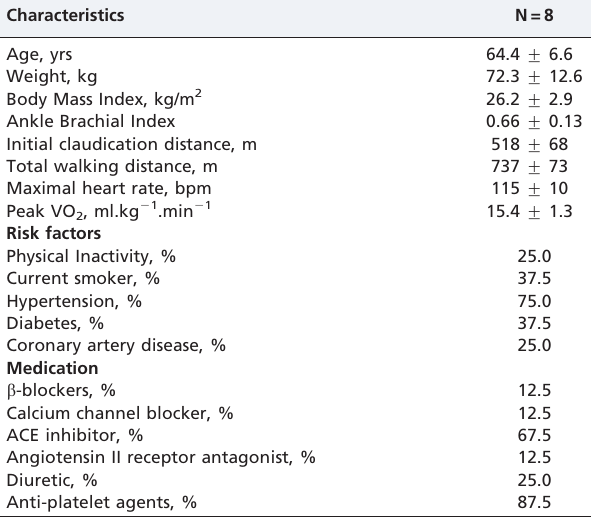
Table 1 - Clinical characteristics of the patients included in the study.